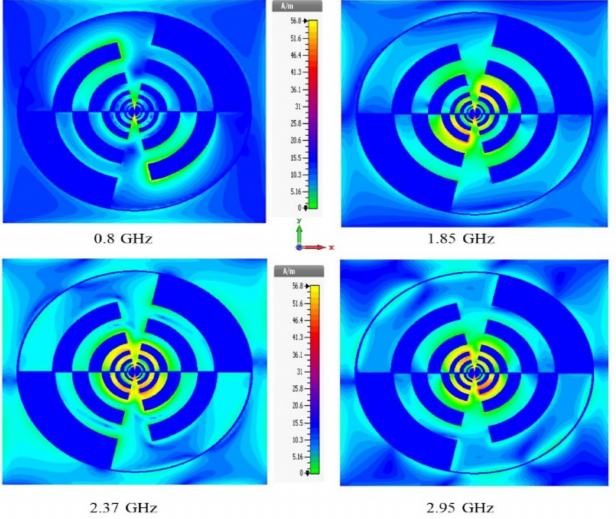
Figure 9. The surface current distribution at operating frequency bands (i.e., 0.78 GHz, 1.8 GHz, 2.38 GHz and 2.9 GHz) on the novel rings log-periodic antenna.